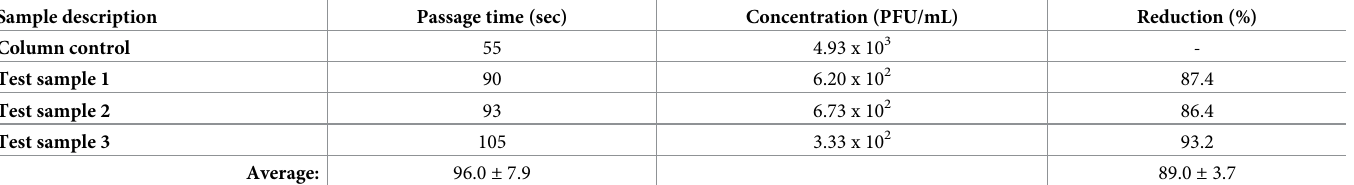
Table 5. NR-54982: Isolate hCoV-19/Japan/TY7-503/2021 (Lineage Brazil P.1).